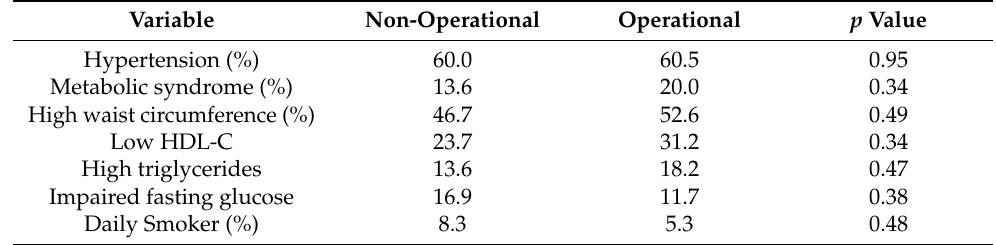
Table 2. Associations of job type with the prevalence of hypertension, metabolic syndrome, metabolic syndrome risk factors, and daily smoking ( n = 137).